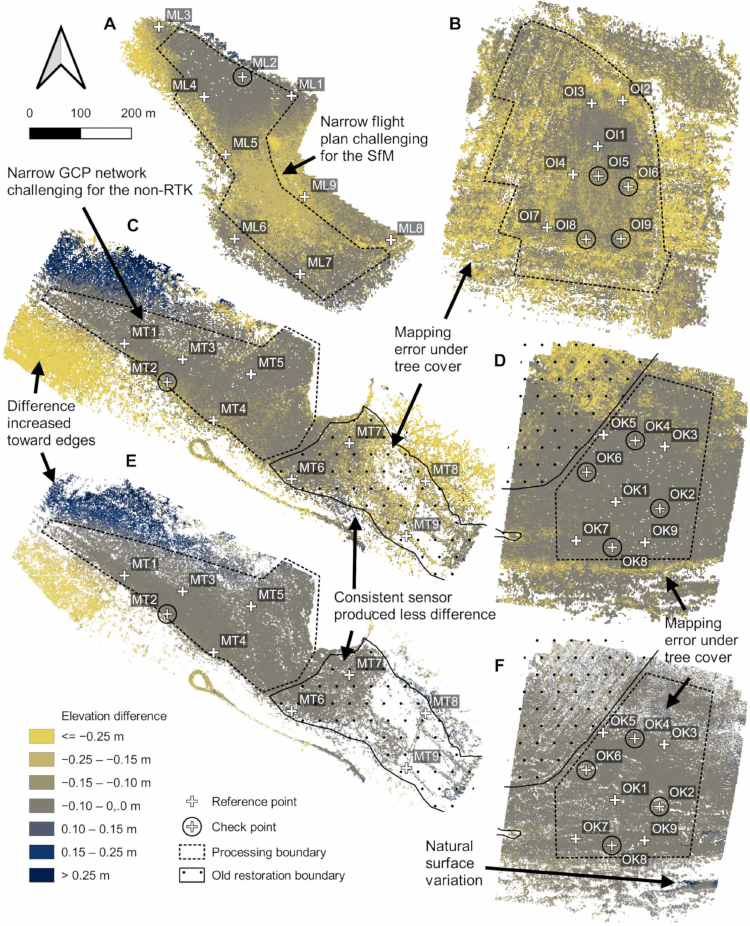
Figure 6. Ground elevation accuracy according to the differences between SfM and the controlling LiDAR data before the restoration. ( A – D ), positive values correspond to the LiDAR surface being higher and between two SfM campaigns at the pristine control site. ( E , F ), positive values correspond to the ground surface elevated by time in Loukkusuo ( A ), Iso Leväniemi ( B ), Tammalampi ( C , E ) and Kirkaslampi ( D , F ). The SfM campaigns of ( A , C ) and the CB campaign of ( E ) have been georeferenced with the GCPs only, which can be seen as decreasing accuracy as the distance from the GCP network increases. The rest of the SfM campaigns have been georeferenced using the onboard-RTK data together with five GCPs, which resulted in a smoother accuracy distribution ( B , D , F ). The checkpoints in ( E ) represent the CB